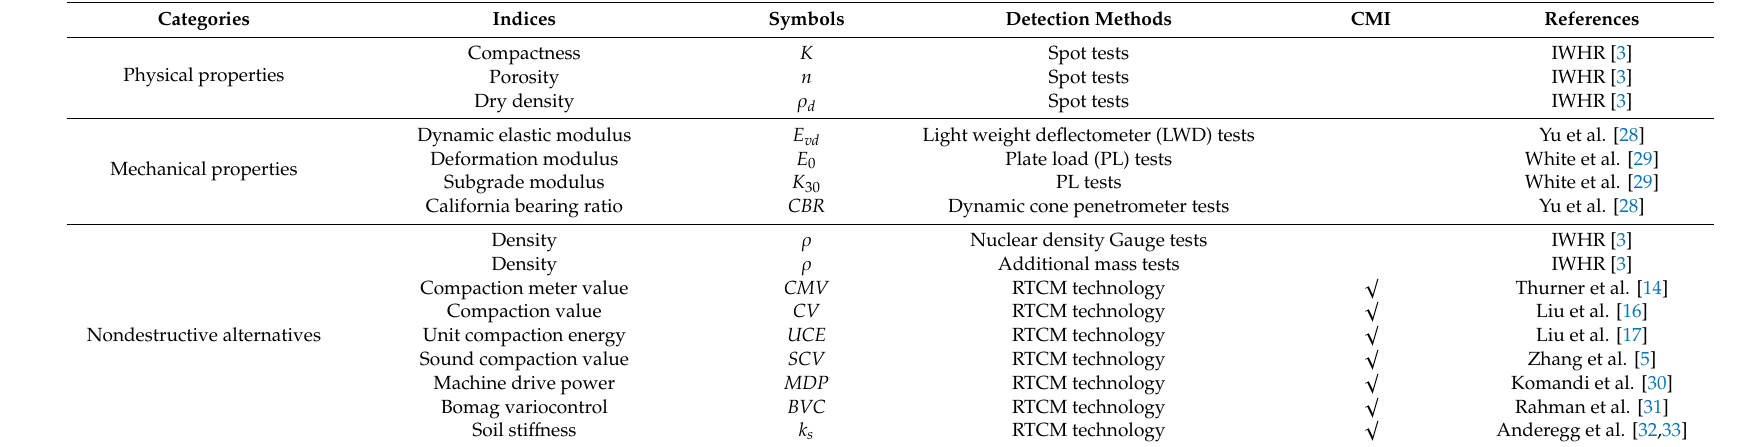
Table 1. Summary of compaction measurement